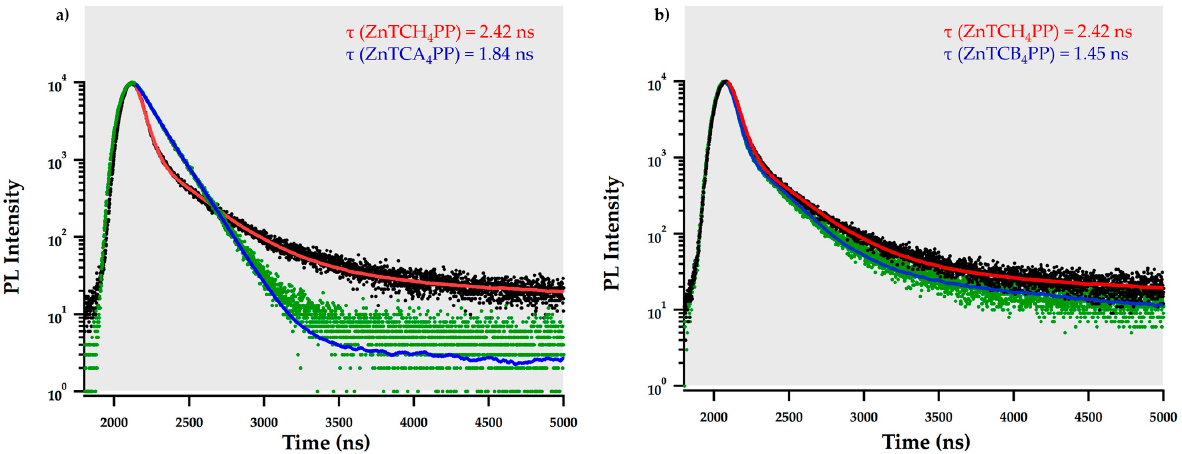
Figure 2. Singlet emission decay lifetime comparison of ( a ) thin film of ZnTCH 4 PP ( - ) and Zn- 5,10,15,20-tetrakis(4-carboxyphenyl)porphyrin solution ( - ) and ( b ) thin films of ZnTCB 4 PP ( - ) and ZnTCH 4 PP ( - ).